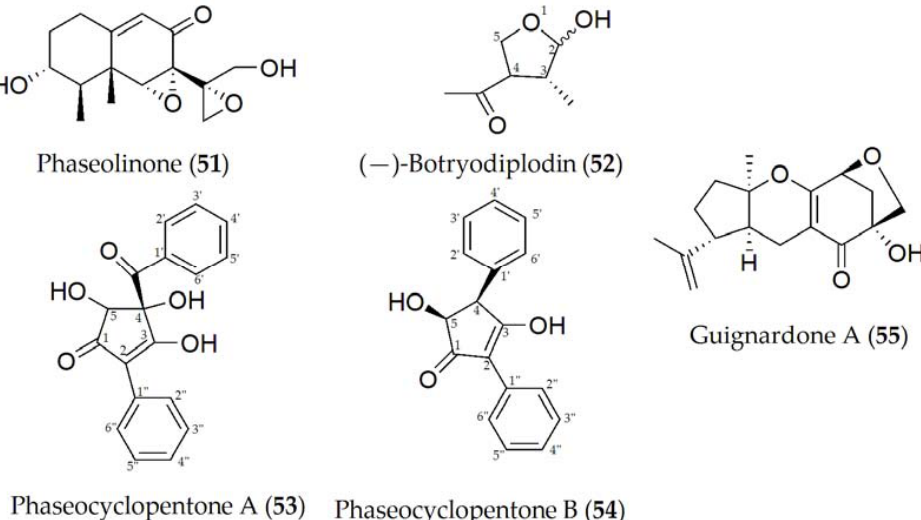
Figure 8. Phytotoxins isolated from Macrophomina phaseolina .